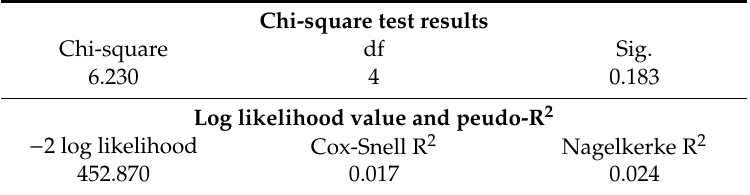
Table 7. Test results and log likelihood value and pseudo-R 2 for the model of the risk of the occurrence of unpaid